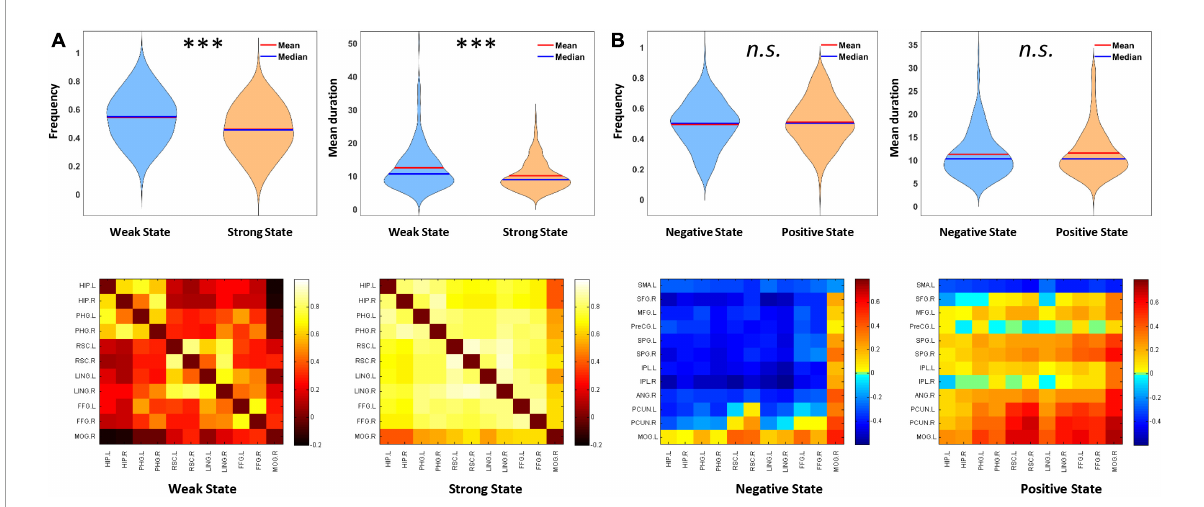
FIGURE3 Properties of representative dynamic functional connectivity (FC) states within the ventral subnetwork (dWNC) and those between ventral and other subnetworks (dBNC). (A) Weak State and Strong State for dWNC. Weak State showed higher frequency, longer mean duration, and weaker FC strength than Strong State. (B) Negative State and Positive State for dBNC. The two states showed no difference in frequency or mean duration. Error bars indicate SEM. *** p < 0.001.